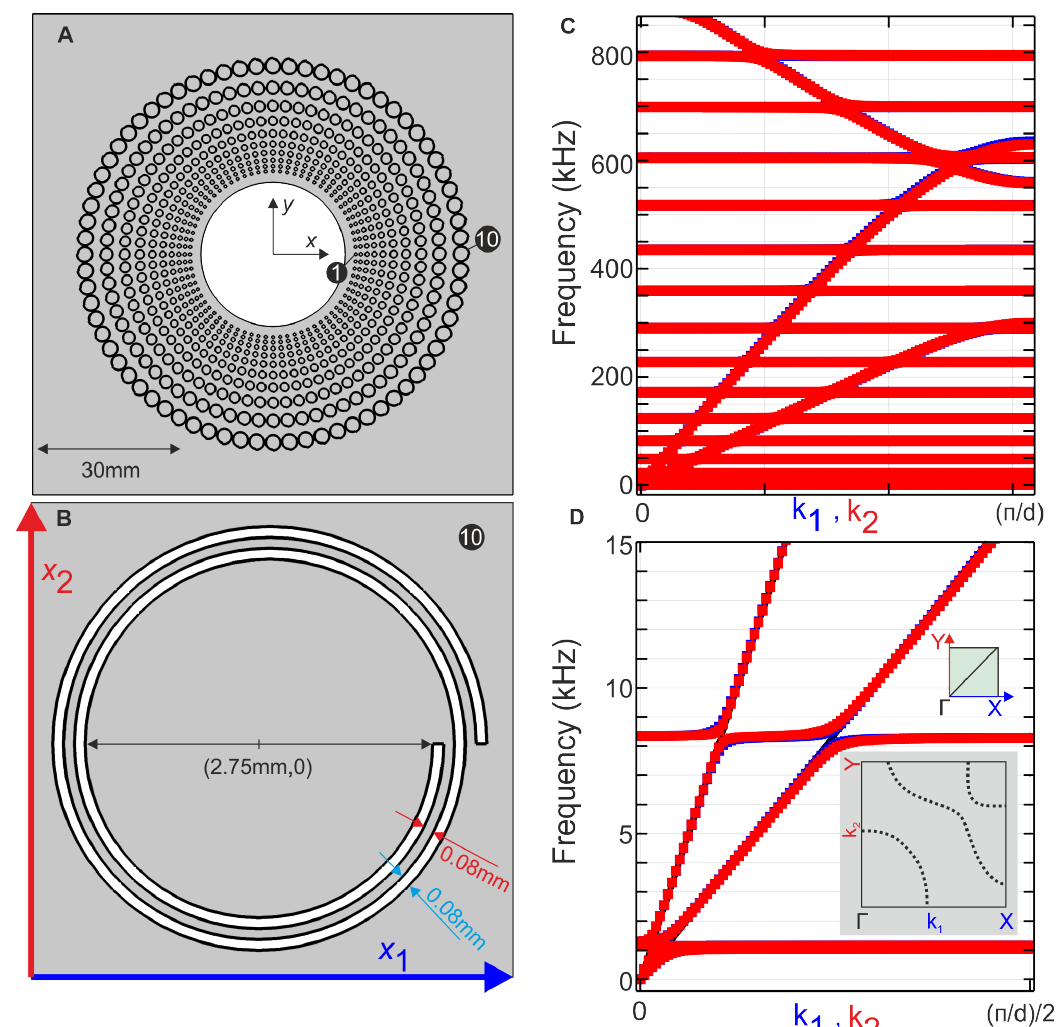
Figure 1. Geometrical characteristics and dispersion properties of the investigated model. ( A ) Geometry of the entire cloak; ( B ) Zoom on an elementary cell; ( C ) Band diagram for a Bloch vector k running along Γ M ( k = ( k 1 ,0 ) with k 1 ∈ [ 0, π / d ] ) and along MY ( k = ( π / d , k 2 ) with k 2 ∈ [ 0, π / d ] ), showing the effective medium is isotropic; ( D ) Zoom-in in the neighborhood of Γ , where one notes the avoided crossings at resonances around 1 kHz and 8 kHz;. These dispersion curves serve as a guide for our homogenized model with an inset showing the isofrequencies around the resonance (approximation of a Willis-type